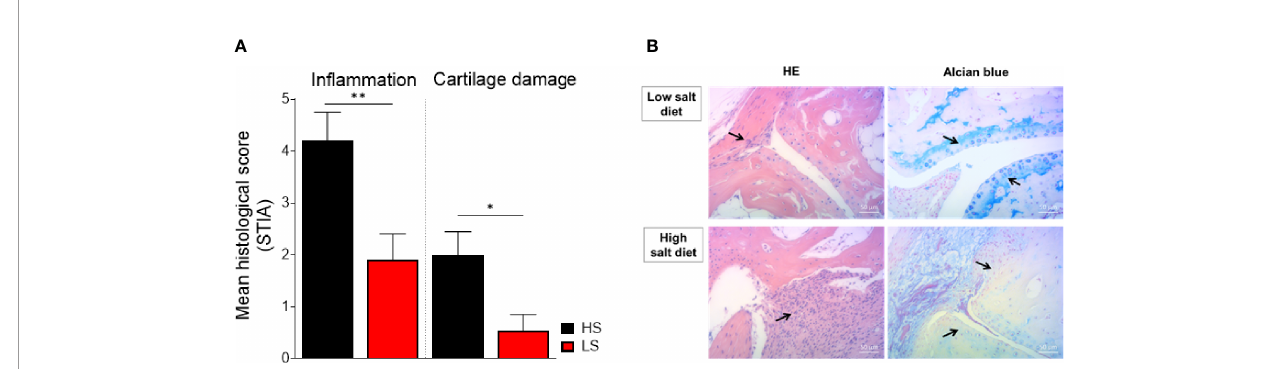
FIGURE 5 | Preventive effect on cell in fi ltration and cartilage loss by low salt diet in STIA. Paraf fi n-embedded sections of hind paws were subjected to hematoxylin/ eosin (HE) and alcian blue staining to investigate the degree of in fl ammation and cartilage damage, respectively. Parameters were scored using a three-graded scale and expressed as mean histological score. (A) Mean histological scores of in fl ammation and cartilage loss are shown in the differently treated STIA mice (LS, n = 10 mice; HS, n = 10 mice). * p < 0.05, ** p < 0.01. p -values were calculated by unpaired Student ’ s t -test. All data were expressed as ± SEM. (B) Representative histopathological images of hind paws stained with HE (left panel) and alcian blue (right panel) of STIA mice on LS diet (upper row) and HS diet (lower row). Arrows indicate pannus formation (HE-stained sections) and cartilage structure (alcian blue-stained